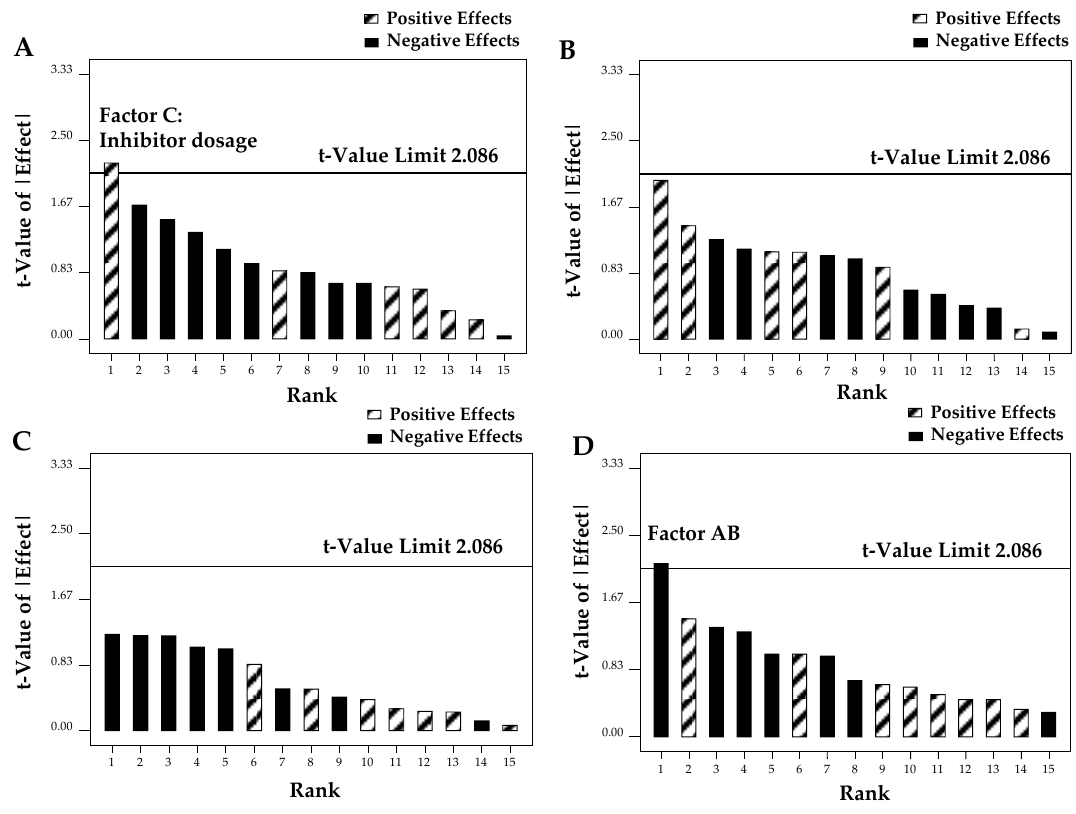
Figure 6. Pareto chart of the absolute values of the standardized effects of the factors for the 4 responses: ( A ) R1: the C content in the froth product; ( B ) R2: the graphite recovery in the froth product; ( C ) R3: the nickel content in the pulp product; and ( D ) R4: the recovery of NMC in the pulp